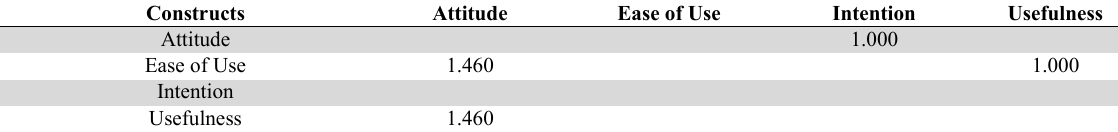
Results of Lateral Collinearity Assessment Constructs Attitude Ease of Use Intention Usefulness Attitude Ease of Use Intention